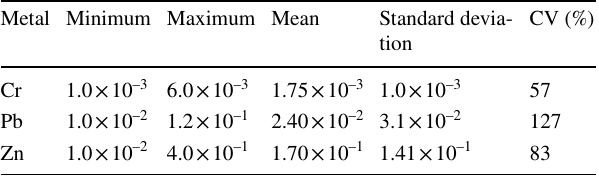
Table 1 Statistical summary of heavy metals in drinking water of Jengka (mg/L)